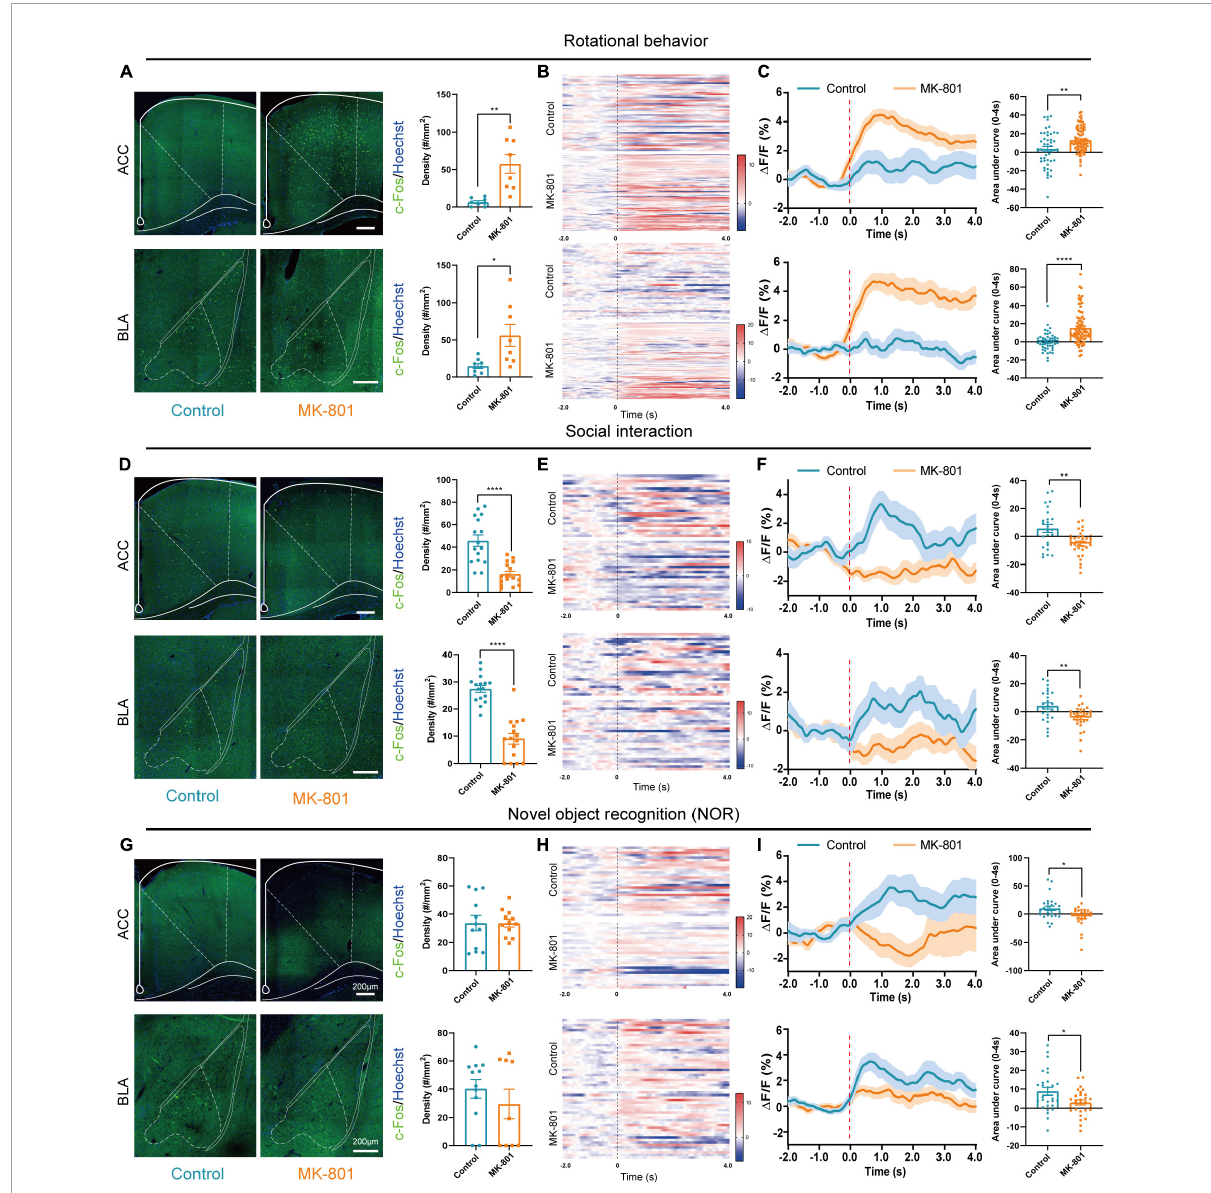
FIGURE2 The anterior cingulate cortex (ACC) and basolateral amygdala (BLA) regions were affected by the MK-801 injection. (A) The c-Fos-positive cells in the ACC (unpaired separate variance estimation t -test, Control n = 8 slices/4 mice, MK-801 n = 8 slices/4 mice) and BLA (unpaired separate variance estimation t -test, Control n = 9 slices/4 mice, MK-801 n = 8 slices/4 mice) of the control and MK-801-treated mice after rotational behavior test. Scale bar, 200 µ m. (B,C) Heatmaps showing Ca 2 + signals aligned to the onset of rotational behavior. Each row represents a trial (B) . Representative traces of the averaged Ca 2 + signals and the area under the curve of the Ca 2 + signal in ACC (unpaired separate variance estimation t -test, Control n = 48 trails/4 mice, MK-801 n = 82 trails/4 mice) and BLA (Mann–Whitney U test, Control n = 48 trails/4 mice, MK-801 n = 82 trails/4 mice) (C) . (D) The c-Fos-positive cells in the ACC (unpaired separate variance estimation t -test, Control n = 18 slices/4 mice, MK-801 n = 16 slices/4 mice) and BLA (unpaired t -test, Control n = 16 slices/4 mice, MK-801 n = 16 slices/4 mice) of the control